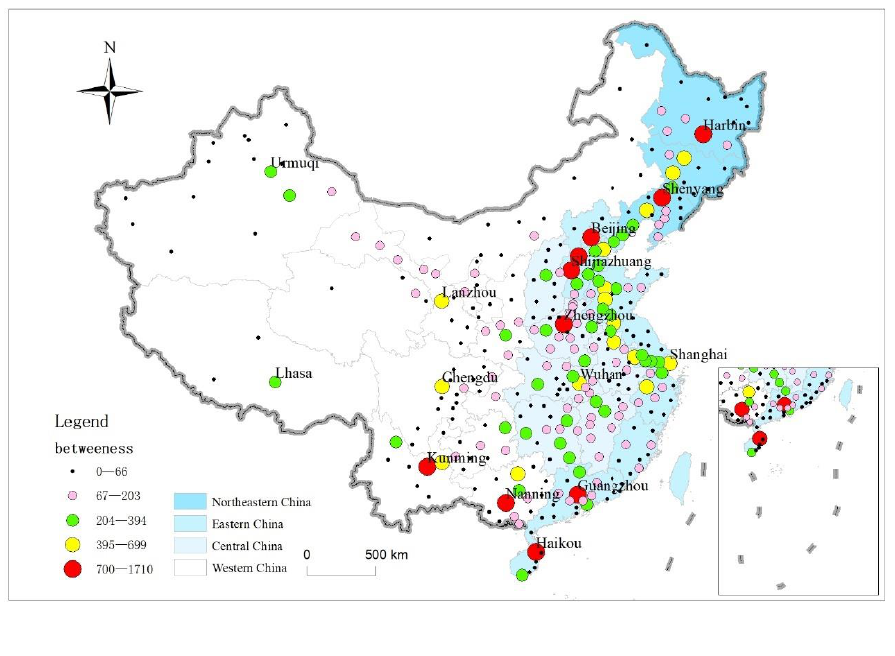
Figure 3. Spatial distributions of different centralities.